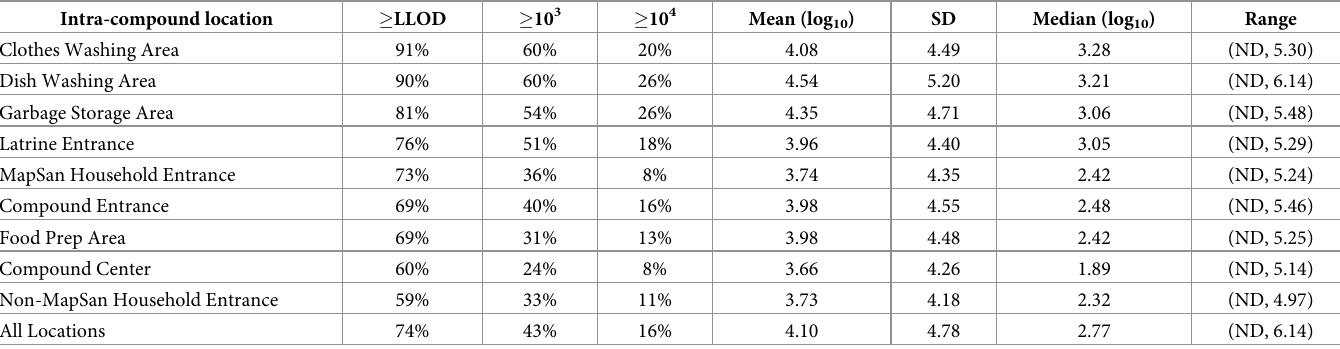
Table 2. CFU E . coli counts at intra-compound